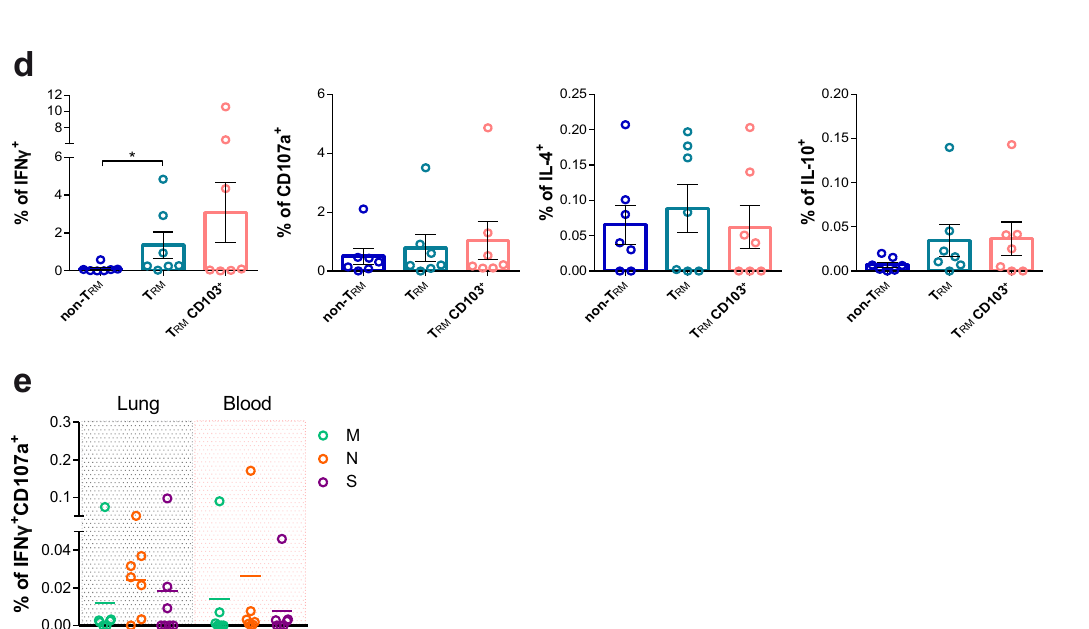
Fig. 6 Functional analysis of lung-resident SARS-CoV-2-speci fi c T cells. a , b Flow cytometry plots showing the frequency of interferon (IFN) γ and degranulation (CD107a) by non-resident memory T cells (T RM ), T RM or CD103 + T RM in CD4 + from HL27 after spike stimulation and control ( a ) and in CD8 + from HL52 after nucleocapsid stimulation and control ( b ). c Heatmaps summarizing the net frequencies of IFN γ , CD107a, interleukin (IL)-4, and IL- 10 SARS-CoV-2-speci fi c CD4 + or CD8 + non-T RM , T RM , and T RM CD103 + from seven different SARS-CoV-2 recovered patients. Cytokine production or degranulation are displayed as colors ranging from yellow to blue, based on the frequency, as shown in the key. d Net frequency of SARS-CoV-2-speci fi c CD3 + T cells in response to all viral proteins (membrane (M), nucleocapsid (N) and spike (S)) from from lung by non-T RM , T RM or CD103 + T RM are shown as mean ± SEM ( n = 7). Statistical comparisons were performed using Kruskal – Wallis rank-sum test with Dunn ’ s multiple comparison test (two-sided): p = 0.023. e Net frequency of double positive IFN γ /CD107a CD3 + T cells from lung or blood after stimulation with membrane (M; green), nucleocapsid (N; orange), or spike protein (S; purple) ( n =